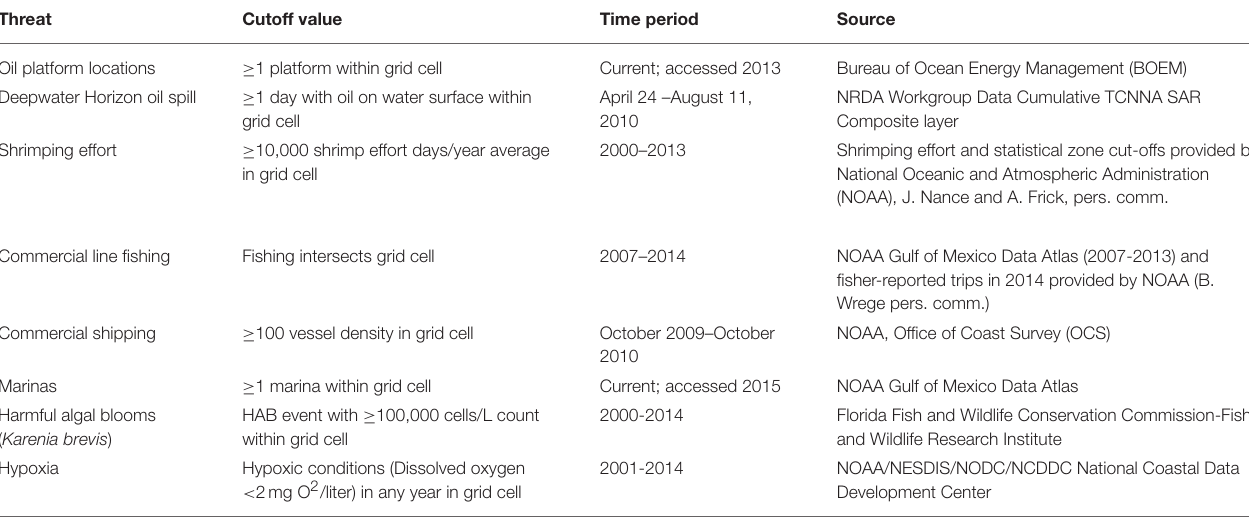
TABLE 1 | Anthropogenic threats in the Gulf of